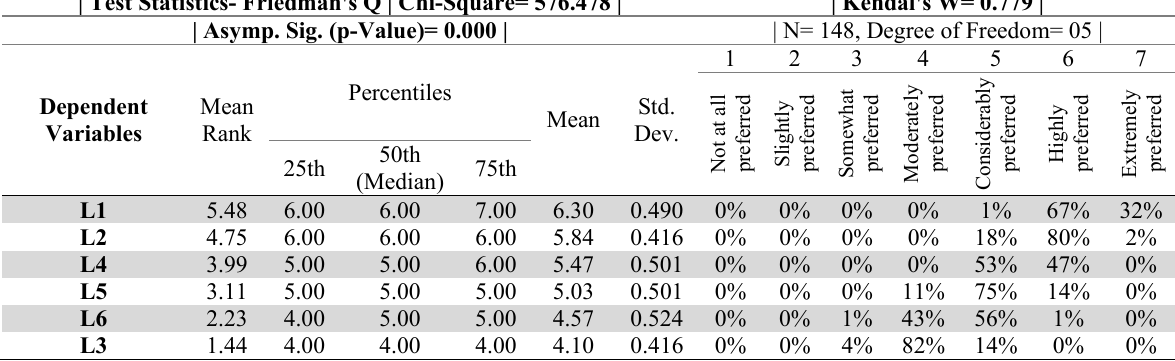
Friedman Q and descriptive statistics- Level of preference towards the outage mitigation methods | Test Statistics- Friedman's Q | Chi-Square= 576.478 |